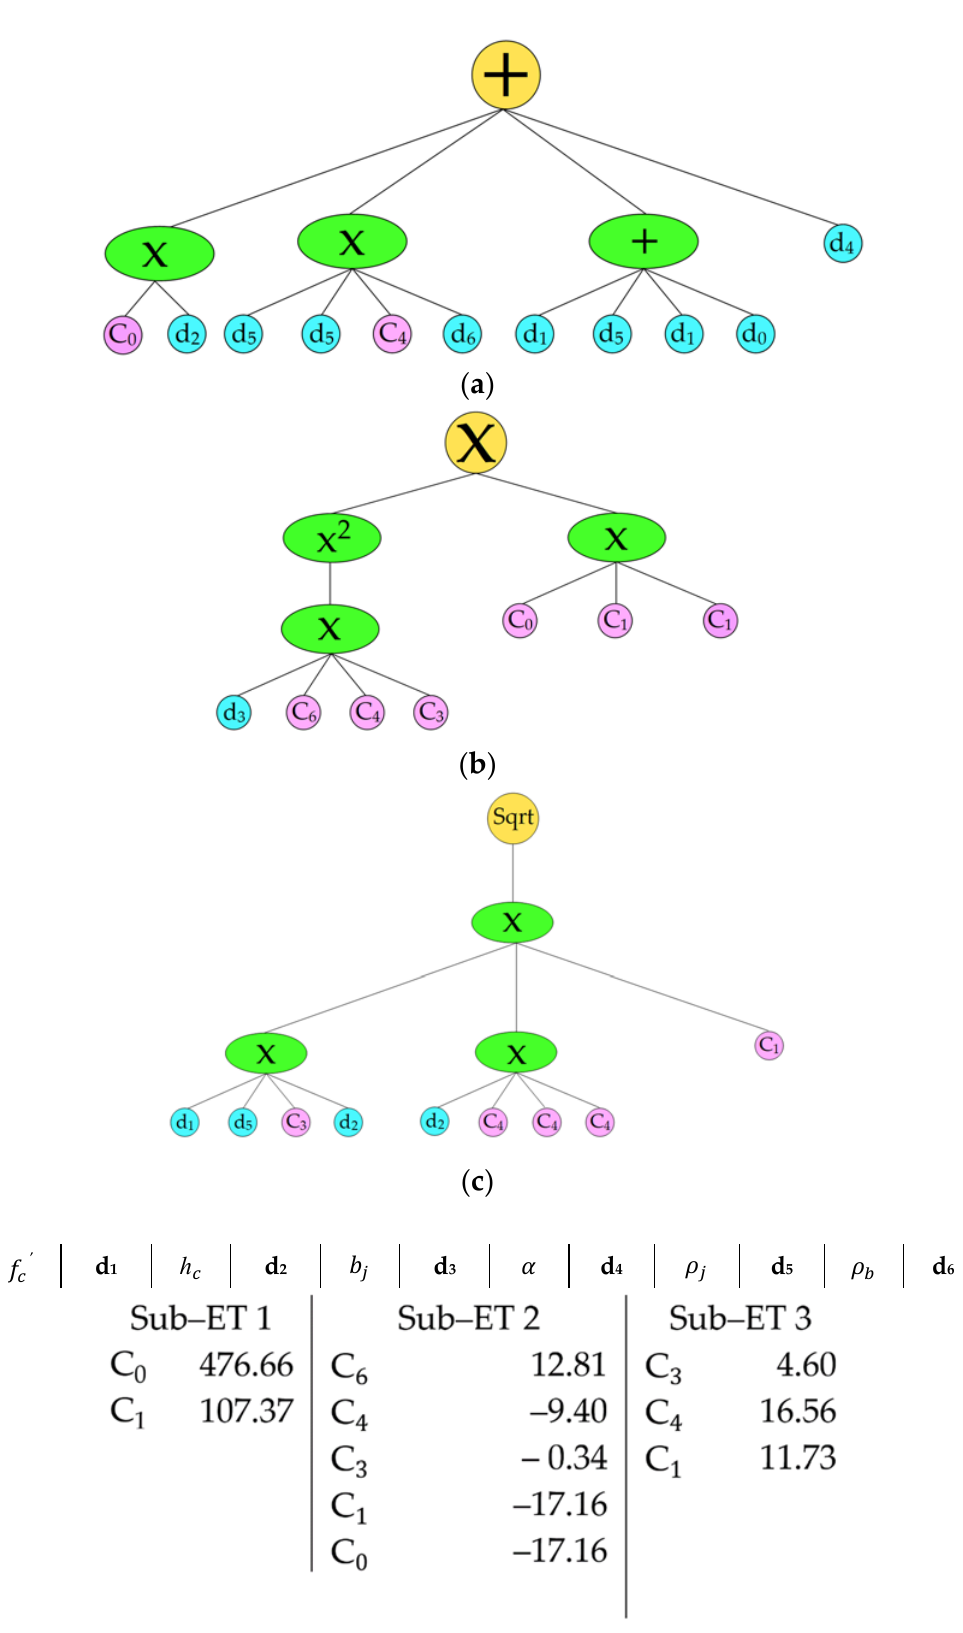
Figure 3. Gene expression tree for the reinforced exterior joint. ( a ) Sub–ET 1 ( b ) Sub–ET 2 ( c ) Sub–ET 3.